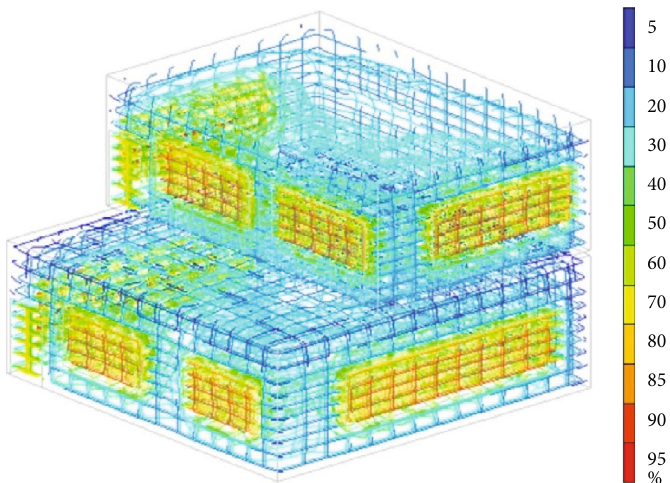
Figure 18: The thermal predicted percentage of dissatis fi ed residents of the studied building (3D